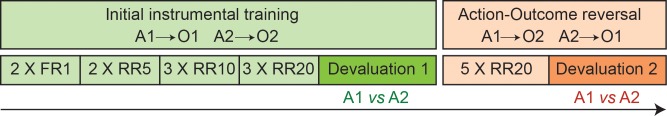
Experimental paradigm to assess flexible goal-directed responding.The design is adapted from Parkes et al. (2018) and consists in providing a choice test following outcome devaluation after an initial instrumental training phase (green), but also after reversal of action-outcome contingencies (orange).